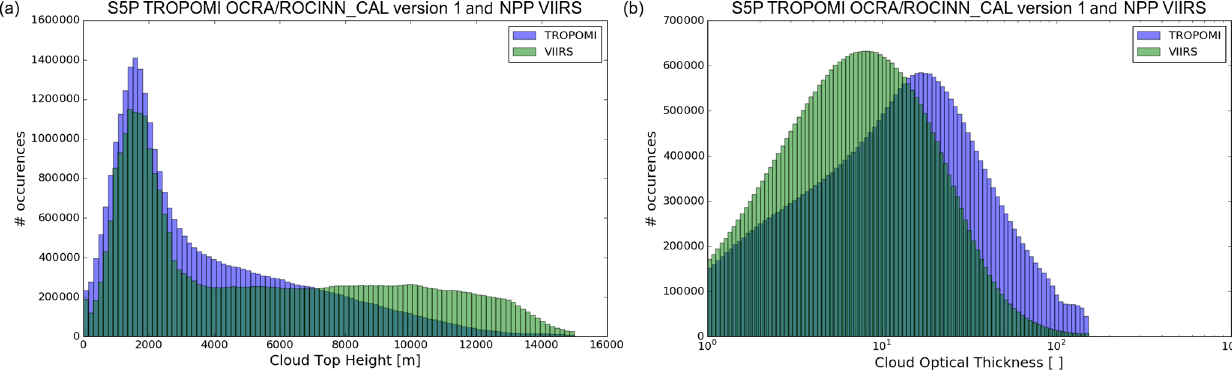
Figure 7. Histograms of the CTH (a) and COT (b) for TROPOMI OCRA/ROCINN_CAL processor version 1 and VIIRS. The complete data set is considered. Note that for TROPOMI the effective COT (i.e. original COT × CRF) is